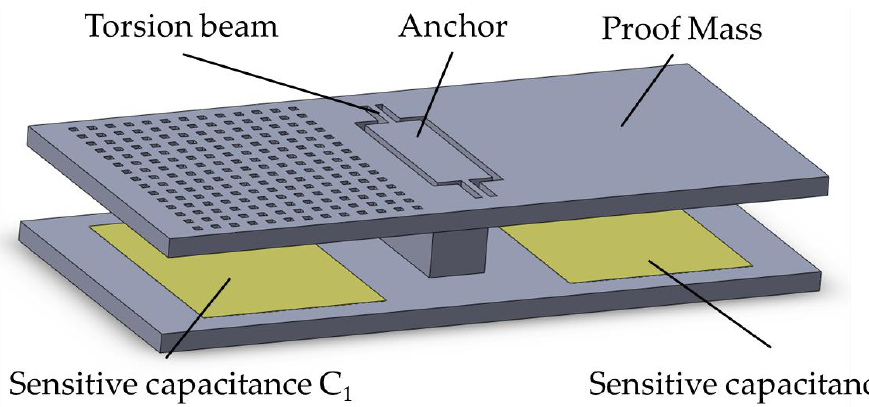
Figure 1. Pendulous capacitive micro-accelerometer.